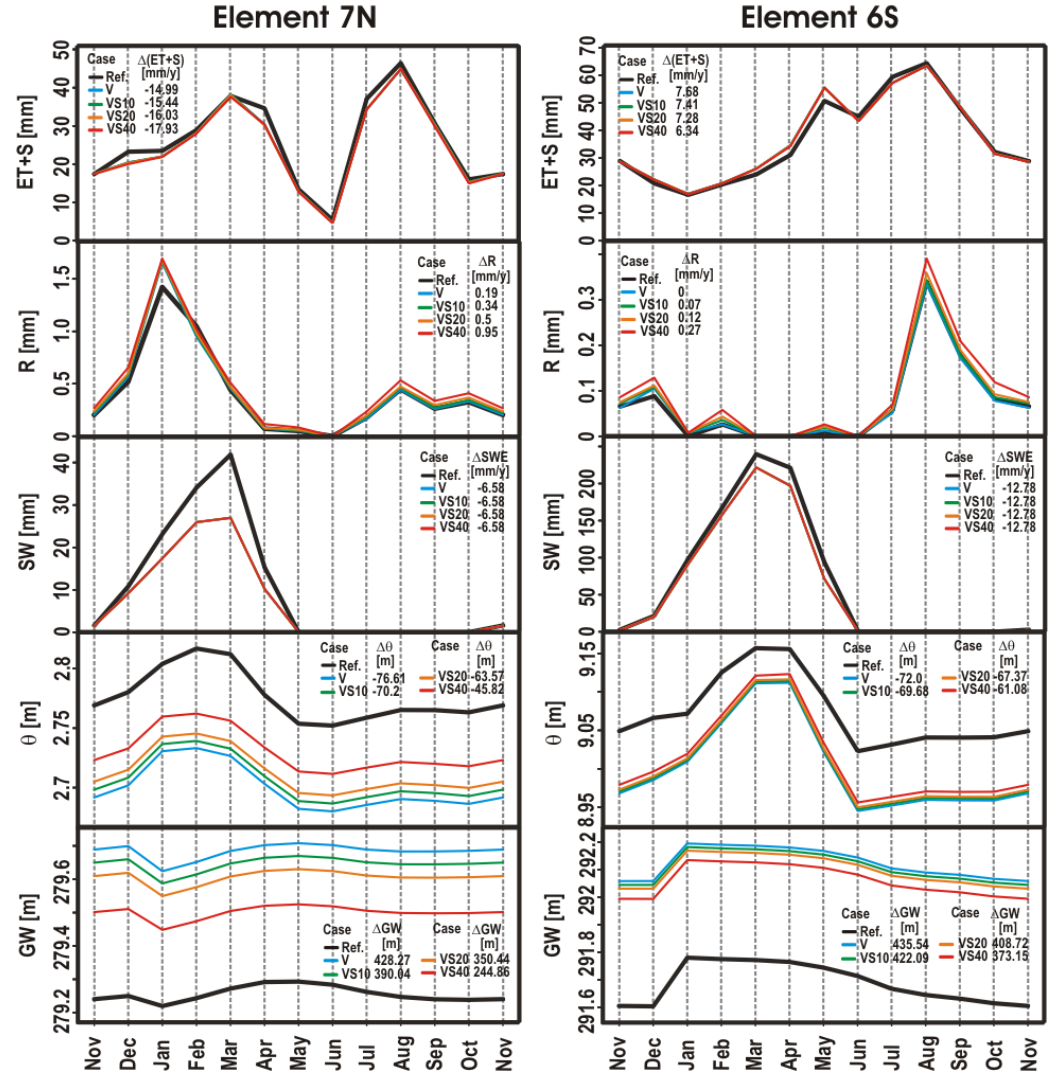
Figure 14. Mean annual cycles of simulated reference (black) and tested (colored) cases for an element pair (7N, 6S) as obtained from 20-year model results. Variables include atmospheric losses (ET+ S ) for all evaporation, transpiration and sublimation rates, net runoff production ( R ), snow water equivalent (SW), vadose zone soil moisture ( θ ) and groundwater storage (GW). V, VS10, VS20 and VS40 are represented by blue, green, orange and red colors, respectively. Mean annual changes ( (cid:49)x ) have been added to each variable to compare mean monthly changes relative to each reference